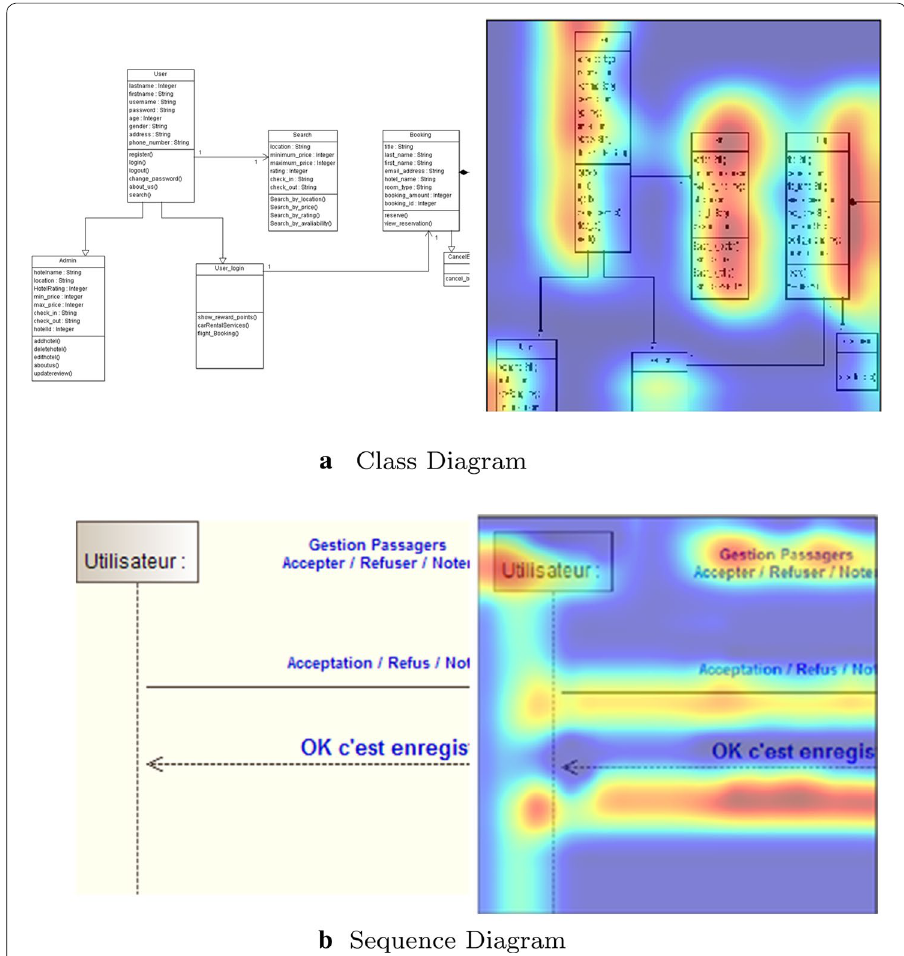
Fig. 3 Original image left, CAM prediction on down-sampled UML diagrams. a A class diagram and b A sequence diagram. The heatmap of the class activation mapping identifies significant features for